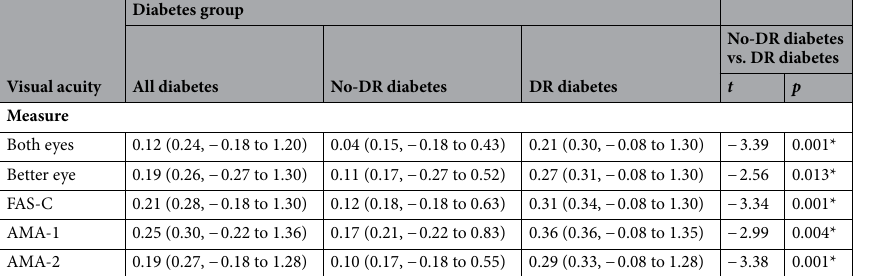
diabetic retinopathy (DR), which included non-proliferative and proliferative diabetic retinopathy. On average, the baseline visual acuity of the better eye/both eyes in the all patients with T2DM, no-DR, and DR groups were 0.19 (SD = 0.26)/0.12 (SD = 0.24), 0.11 (SD = 0.17)/0.04 (SD = 0.15), and 0.27 (SD = 0.31)/0.21 (SD = 0.30) logMAR, respectively. Binocular acuity was better than that of the better eye across the three groups. There were